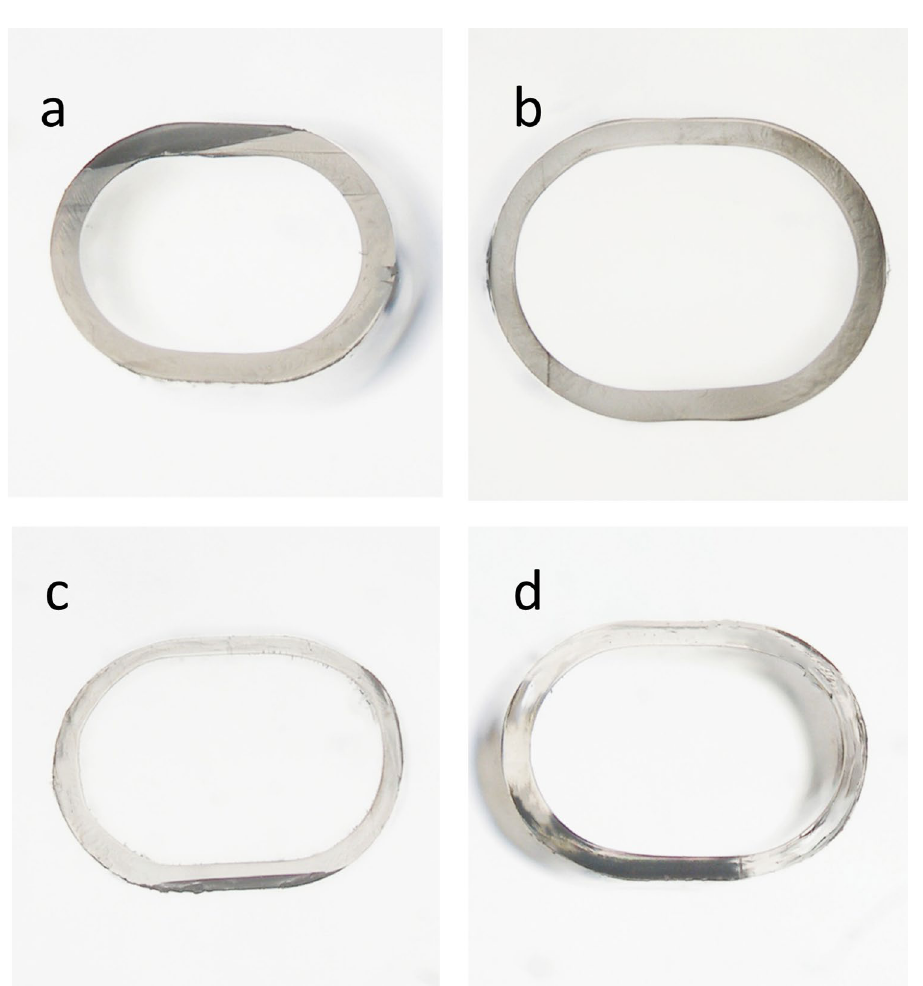
Figure 1. Representative microscopic images of cross-section surfaces for all injector systems (under ×4 magnification). ( a ) Monarch III D Cartridge. ( b ) AcrySert C. ( c ). UltraSert. ( d ).